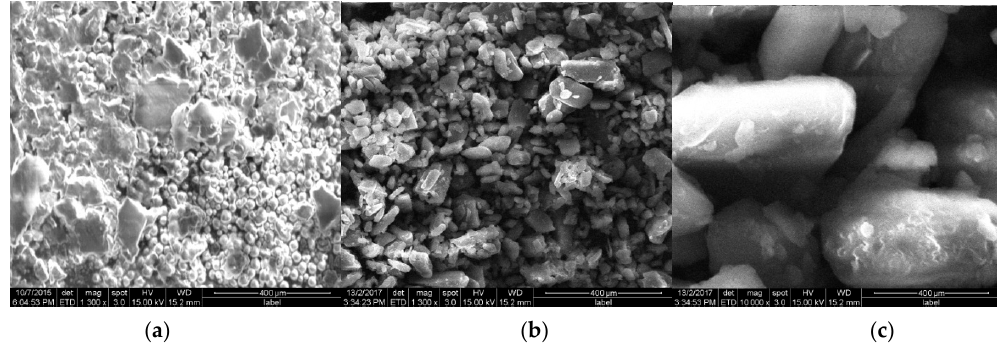
Figure 4. Scanning electron microscopy (SEM) of OG ( a ) and TOG at low magnification ( b ) and TOG at high magnification ( c ).